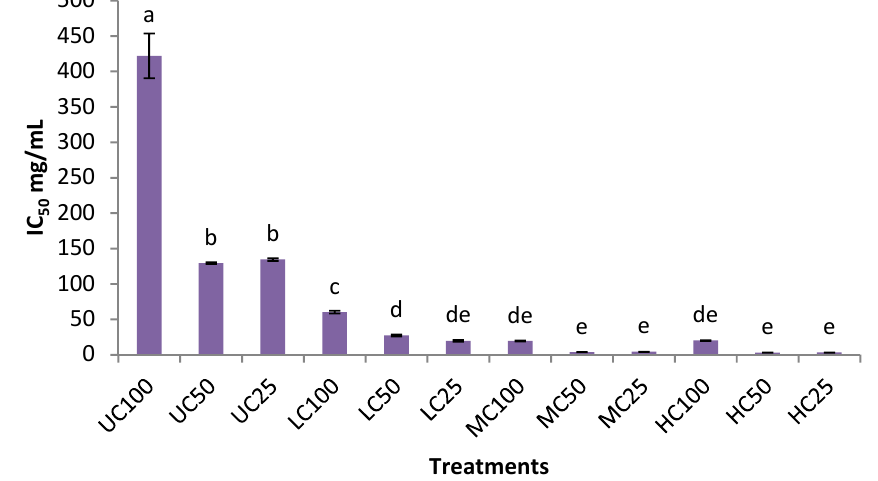
Figure 4. DPPH scavenging of air-fried eggplant. The treatment codes consisting of different letters and digits represent the uncooked (UC), high-cooked (HC), medium-cooked (MC), and low-cooked (LC) eggplant samples extracted with absolute ethanol (100), 50% ethanol (50), and 25% ethanol (25). The bars containing different letters are significantly different from each other ( p < 0.05).